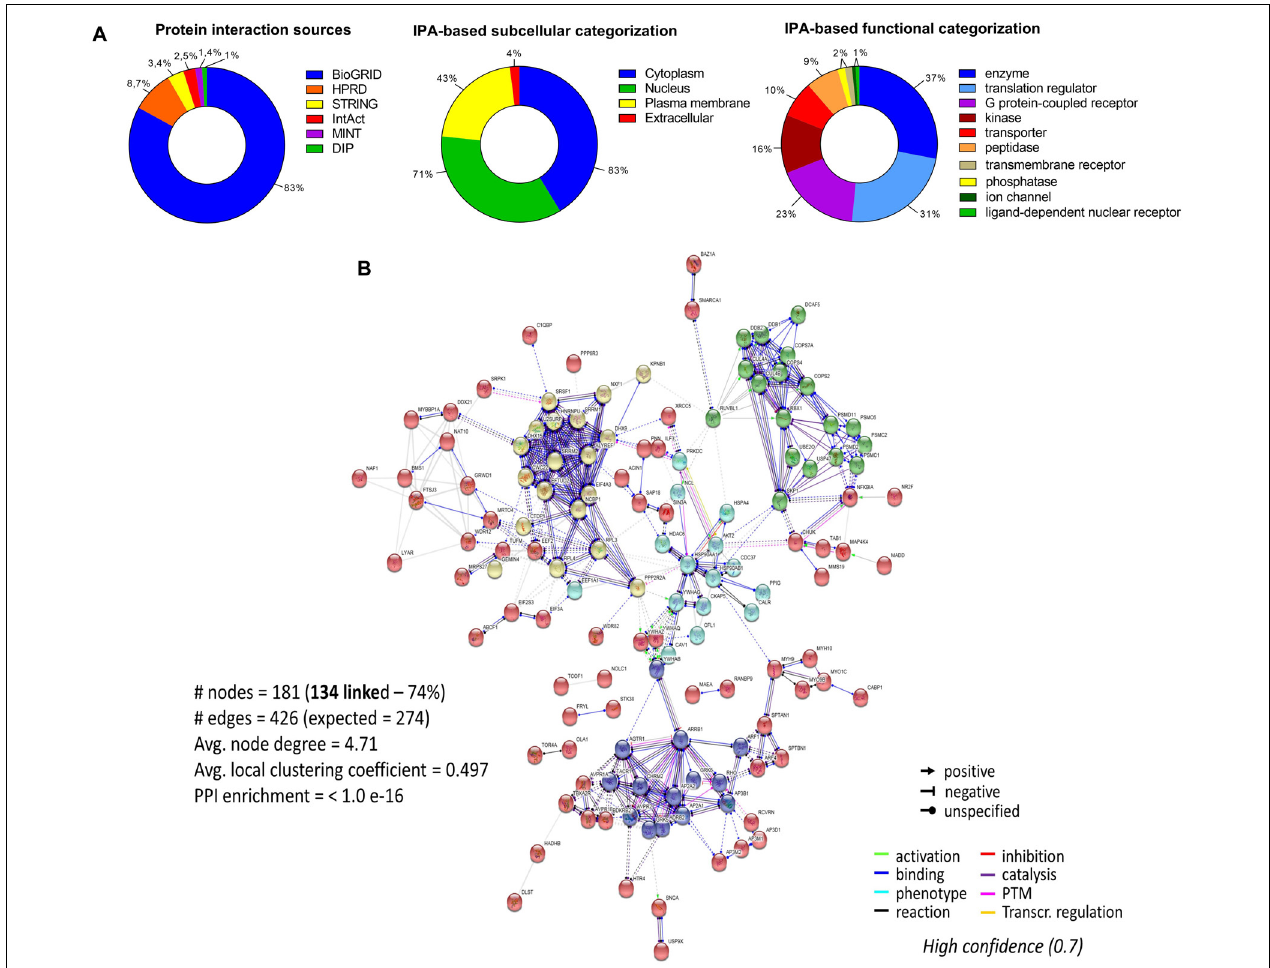
FIGURE 2 | Molecular analysis of the functional GRK5 interactome. The interactors of a protein are indicative of its function. Thus, to further investigate the function of GRK5 we extracted empirically identified GRK5 interacting partners from multiple informatics databases, BioGrid (https://thebiogrid.org/), HPRD (Human Protein Reference Database: http://www.hprd.org/), IntAct (https://www.ebi.ac.uk/intact/), MINT (The Molecular INTeraction Database), STRING (https://string-db.org/) and DIP (Database of Interacting Proteins: http://dip.mbi.ucla.edu/dip/). This curation generated a list of 183 proteins which are proven interactors of GRK5 (A) . The left panel indicates the distribution of the curated proteins from the aforementioned databases. This dataset was further analyzed using Ingenuity Pathway Analysis (IPA) to first create an unbiased assessment of the subcellular distribution (center panel) of the interactors and then secondly a functional categorization of the GRK5 interactors (right panel). Using our curated 183 protein input we employed STRING to investigate the strength of interactions between these diverse GRK5 interacting proteins. With this we applied a “strong” cut-off strength of confidence (0.7) and also limited the protein-protein interaction types to those empirically observed in physical interaction of co-expression experiments. In addition, all unconnected nodes were removed from the network (B) . K-means clustering was employed to group the interacting proteins in the network into five main clusters (blue, red, yellow, mint, and dark